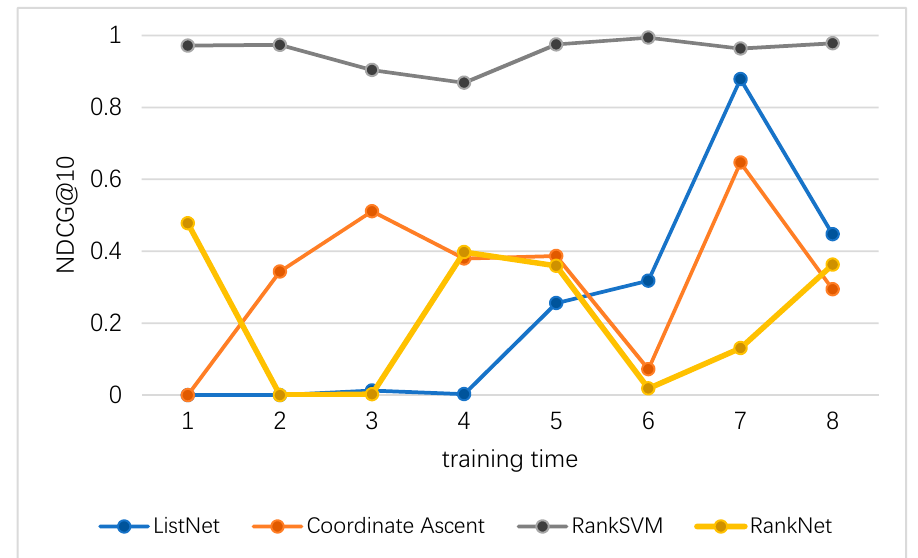
Figure 6. Training effect of learning-to-rank.